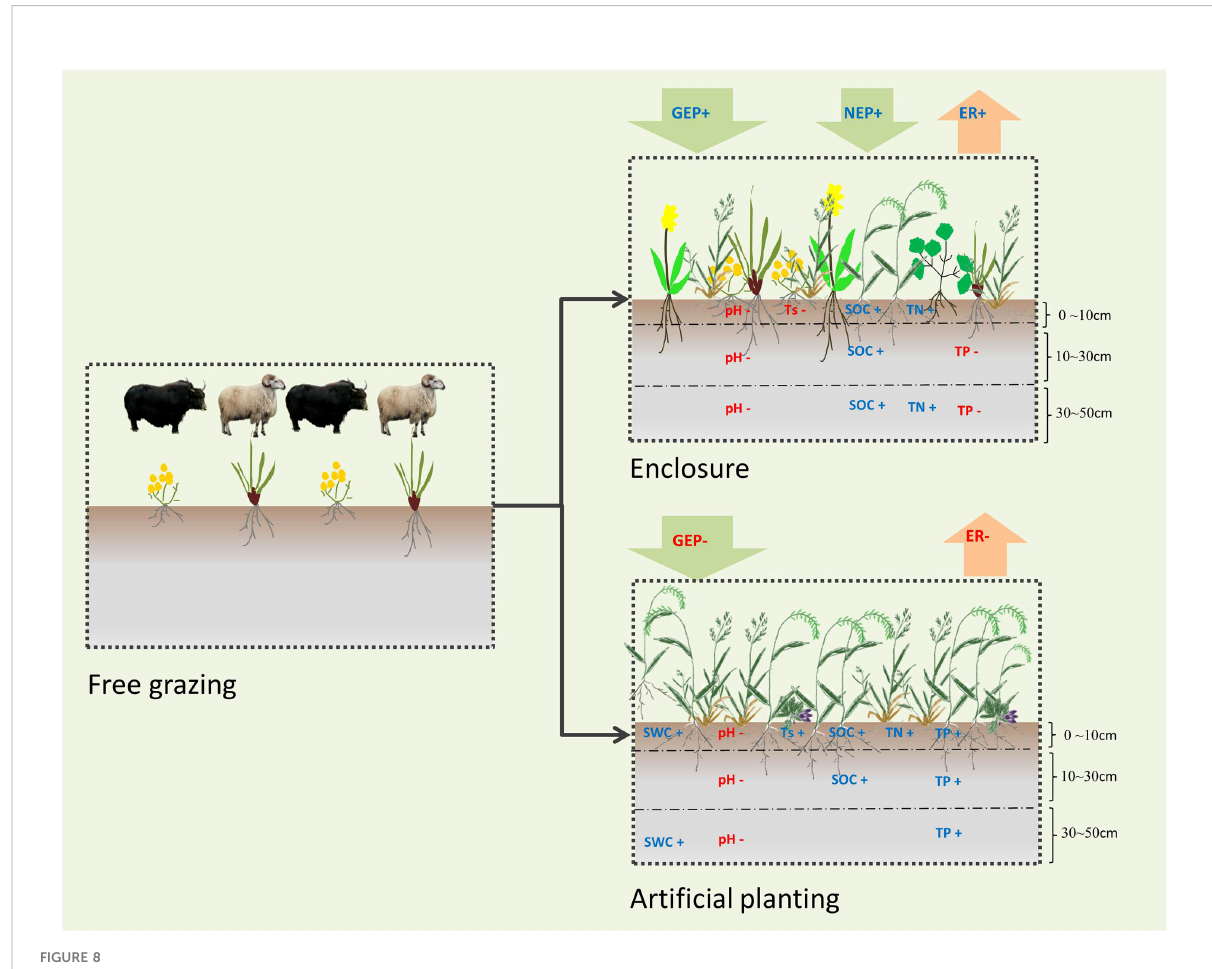
FIGURE 8 Concept map of different grassland managements on carbon fl uxes, vegetation and soil characteristics of alpine meadow. NEP, net ecosystem production; GEP, gross ecosystem production; ER, ecosystem respiration; SWC, soil water content; Ts, soil temperature; SOC, soil organic carbon; TN, total nitrogen; TP, total phosphorus. For clarity, not all variables of our study are listed. Only the variables with signi fi cant changes compared with free grazing are listed. The blue word and red word indicates variables under the current management mode signi fi cantly increase or decrease compared with free